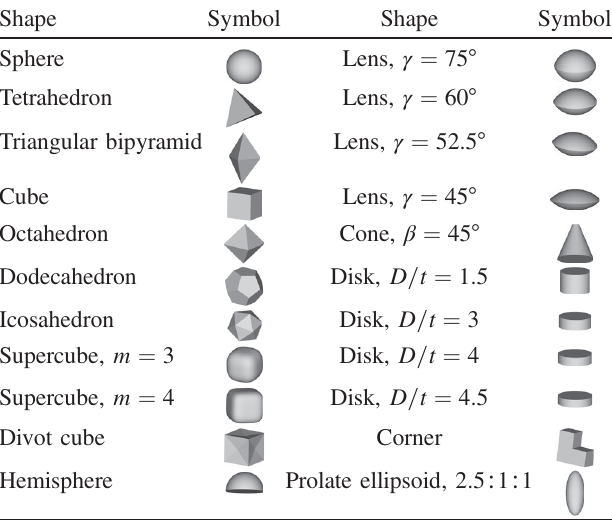
TABLE I. Particle shapes. A triangular bipyramid is two tetrahedra joined face to face. A supercube surface is defined by j x j m þ j y j m þ j z j m ¼ R m , with m ¼ 2 corresponding to a sphere and m ¼ ∞ a cube. A divot cube has a right pyramid removed from each face such that edges sharpen from 90° to